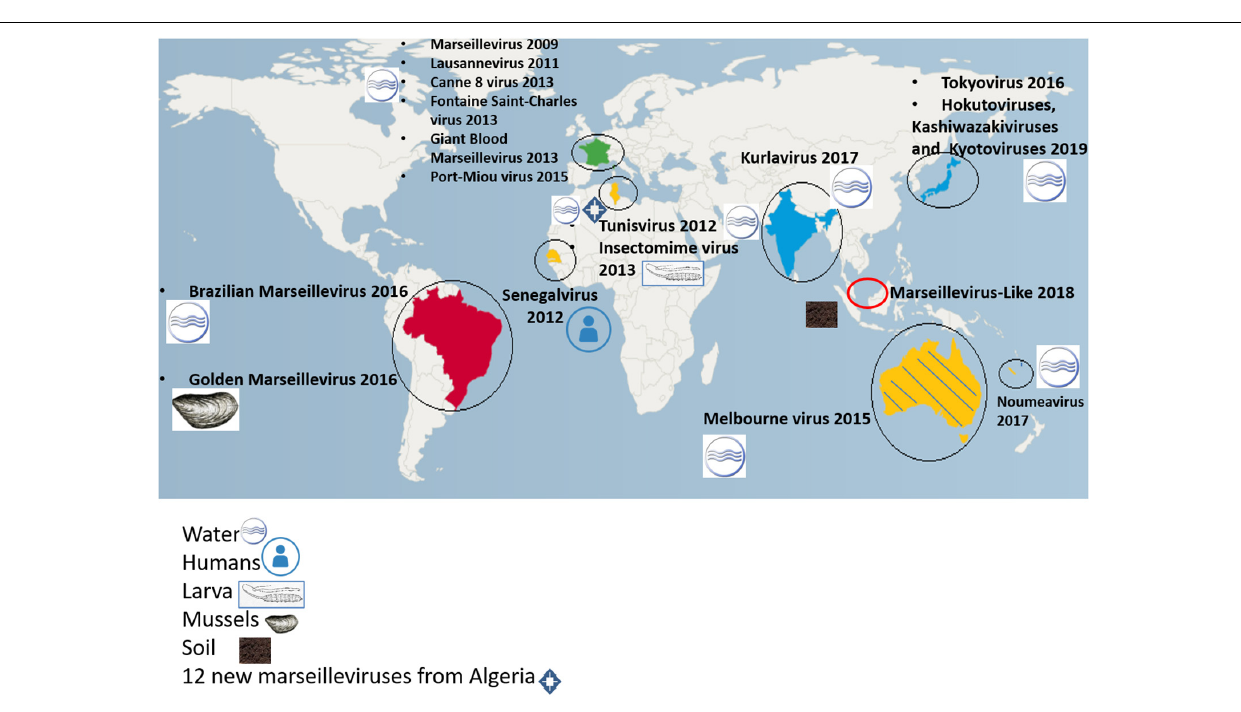
FIGURE 2 | Worldwide distribution of isolated